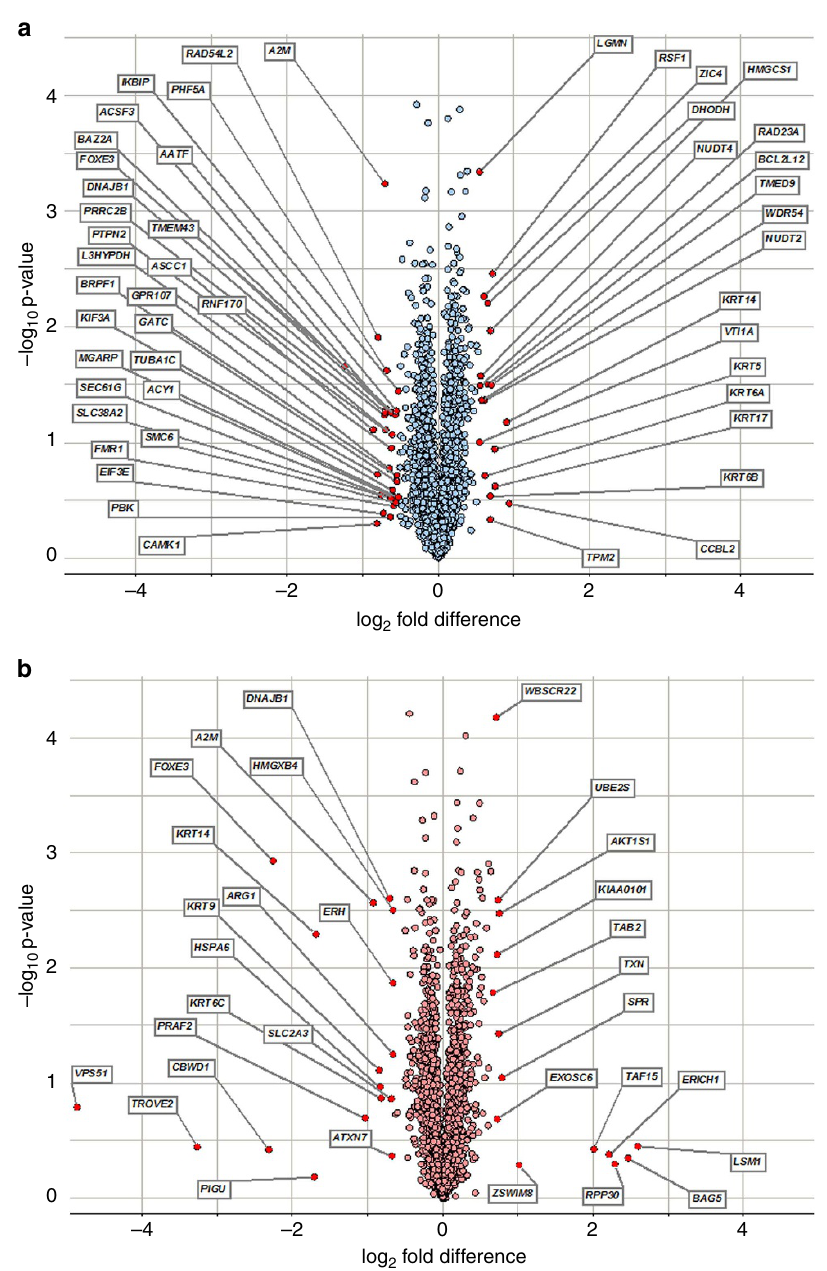
Figure 2 | Volcano plot of differentially regulated proteins in HEK293 cells expressing mutant (p.C240*) FOXE3. ( a ) The iTRAQ protocol identified 48 differentially expressed proteins, of which 29 were downregulated and 19 upregulated in cells expressing mutant FOXE3. ( b ) The TMTprotocol revealed a total of 31 proteins that were differentially expressed including 17 downregulated and 14 upregulated in cells expressing mutant FOXE3. Note: the fold changes are represented in log 2 scale depicted on the x -axis and the (cid:2) log 10 p -value is depicted on the y -axis (the use of (cid:2) log values means that proteins having greater statistical significance are higher in the plot). The red circles in both plots represent proteins that show 3 s.d. differential